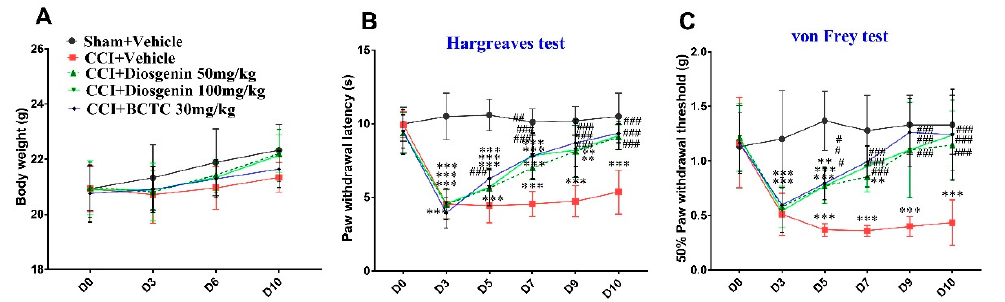
Figure 6. Effects of diosgenin on body weight ( A ), paw withdrawal latency ( B ), and paw withdrawal threshold ( C ) in a mouse model of chronic constriction injury.; BCTC: N -(4-tertiarybutylphenyl)-4-(3-cholorphyridin-2-yl) tetrahydropyrazine-1(2H)-carbox-amide; CCI: chronic constriction injury. Data are presented as mean ± standard error of mean (n = 10), * p < 0.05 and *** p < 0.001, Bonferroni post hoc test following two-way RM ANOVA versus the sham + vehicle group; # p < 0.05; ## p < 0.01; and ### p < 0.001, Bonferroni post hoc test following two-way RM ANOVA versus the CCI + vehicle group.